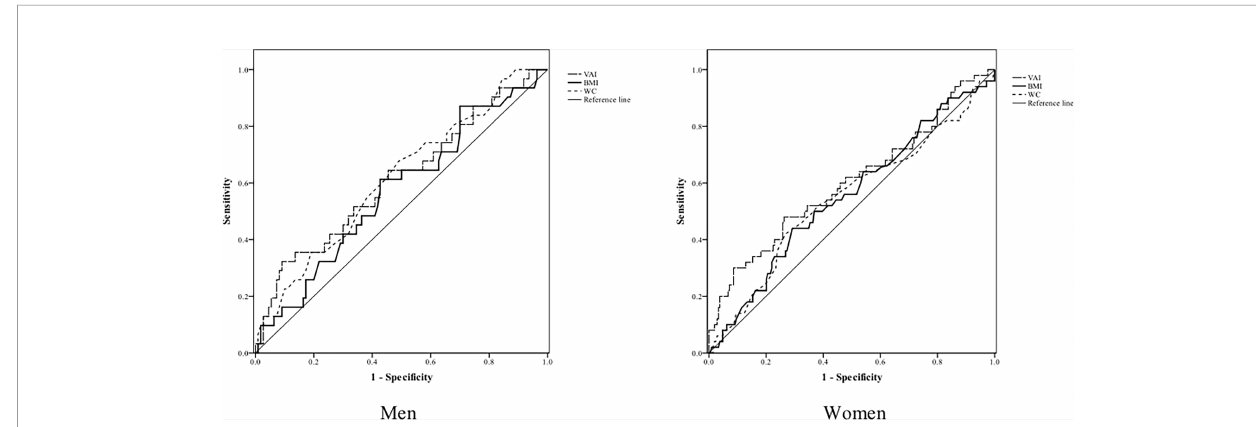
FIGURE 2 | ROC curves for obesity indices as discriminators of CKD in men and women.